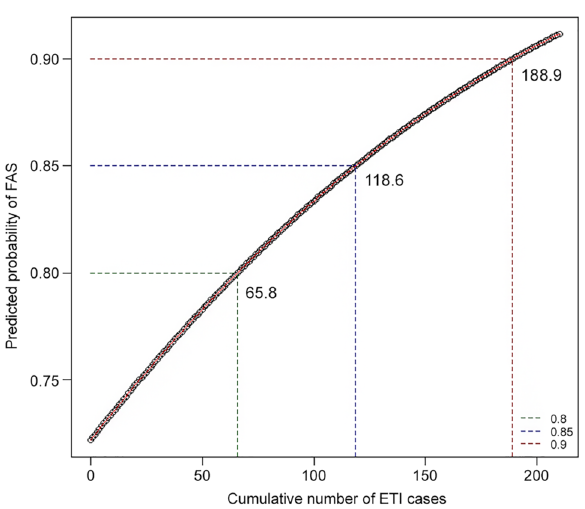
Figure 2. Relation between the cumulative number of ETI cases and predicted probability of first attempt success. Generalized linear mixed models with random intercept using the logit link function were used to estimate the probability of FAS according to the cumulative number of ETI cases. FAS first attempt success, ETI endotracheal